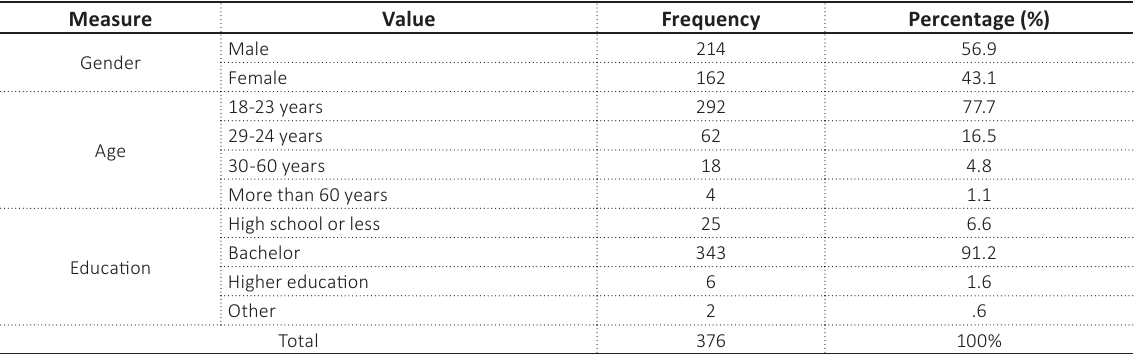
Table 1. Sample characteristics